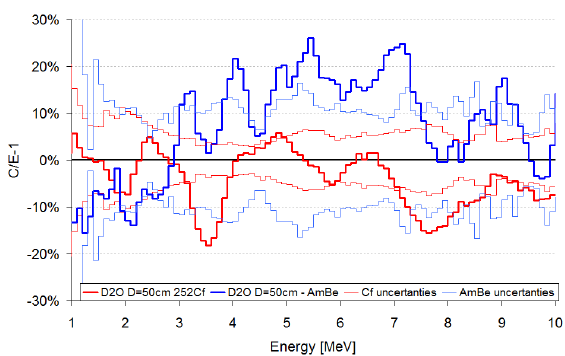
Figure 5. C / E-1 for ENDF / B-VII.1 for and AmBe leakage flux. C / E-1 of leakage flux of 252 Cf and AmBe sources in D 2 O sphere of diameter 50 cm (calculation in ENDF /